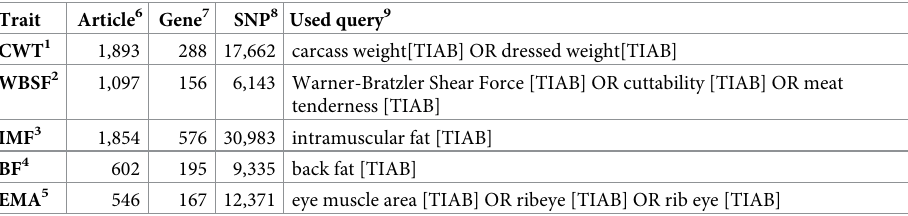
Table 1. Summary statistics of text mining and SNP